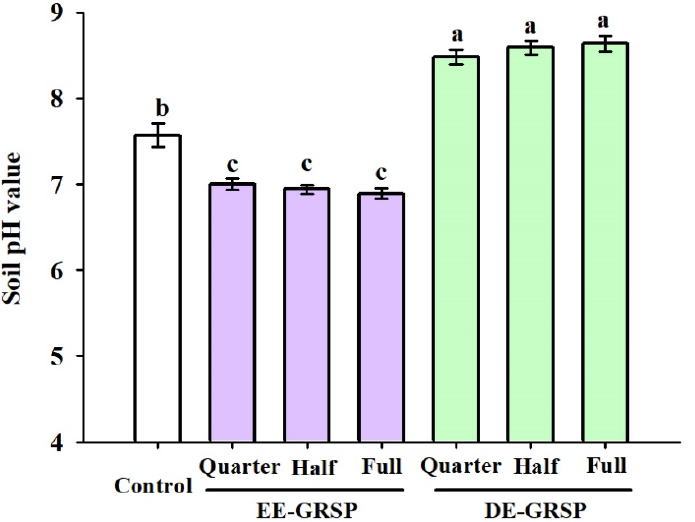
Figure 3. Effects of exogenous EE-GRSP and DE-GRSP on the soil pH value in the rhizosphere of trifoliate orange seedlings. Data (means ± SD, n = 4) followed by different letters above the bars indicate significant differences ( p < 0.05) between